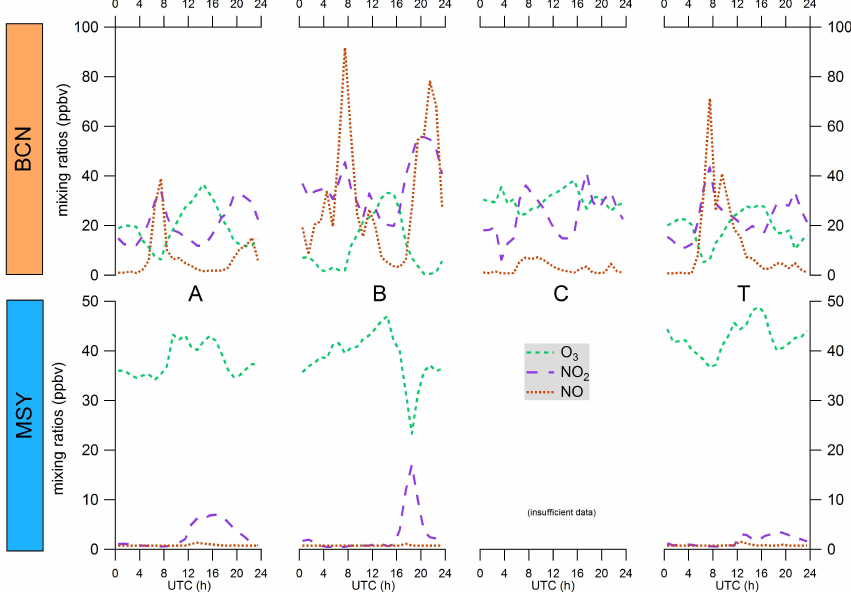
Fig. 5. Average NO, NO 2 and O 3 mixing ratios for each atmospheric scenario at BCN (top panels) and MSY (bottom panels). Note the different scaling between top and bottom